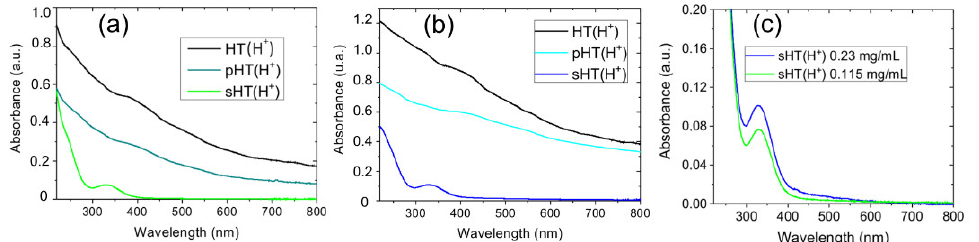
Figure 1. UV-Vis absorbance spectra of acid treated HT samples (black curves), supernatants and precipitates at 0.115 mg/mL ( a ) and 0.23 mg/mL ( b ) initial concentrations, respectively. A comparison of supernatants’ solutions for both concentrations is reported in ( c ).